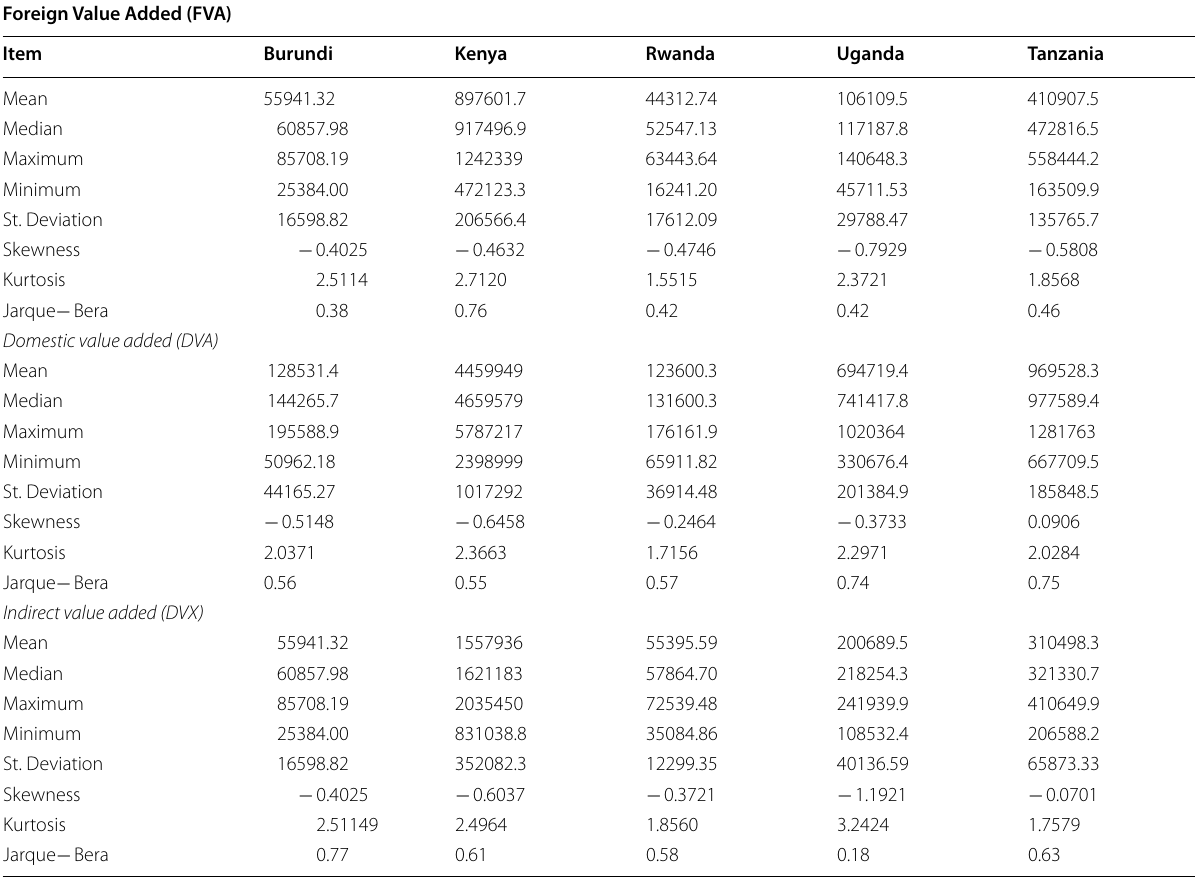
Table 1 A descriptive statistics of the export share of the East African Community (EAC) member